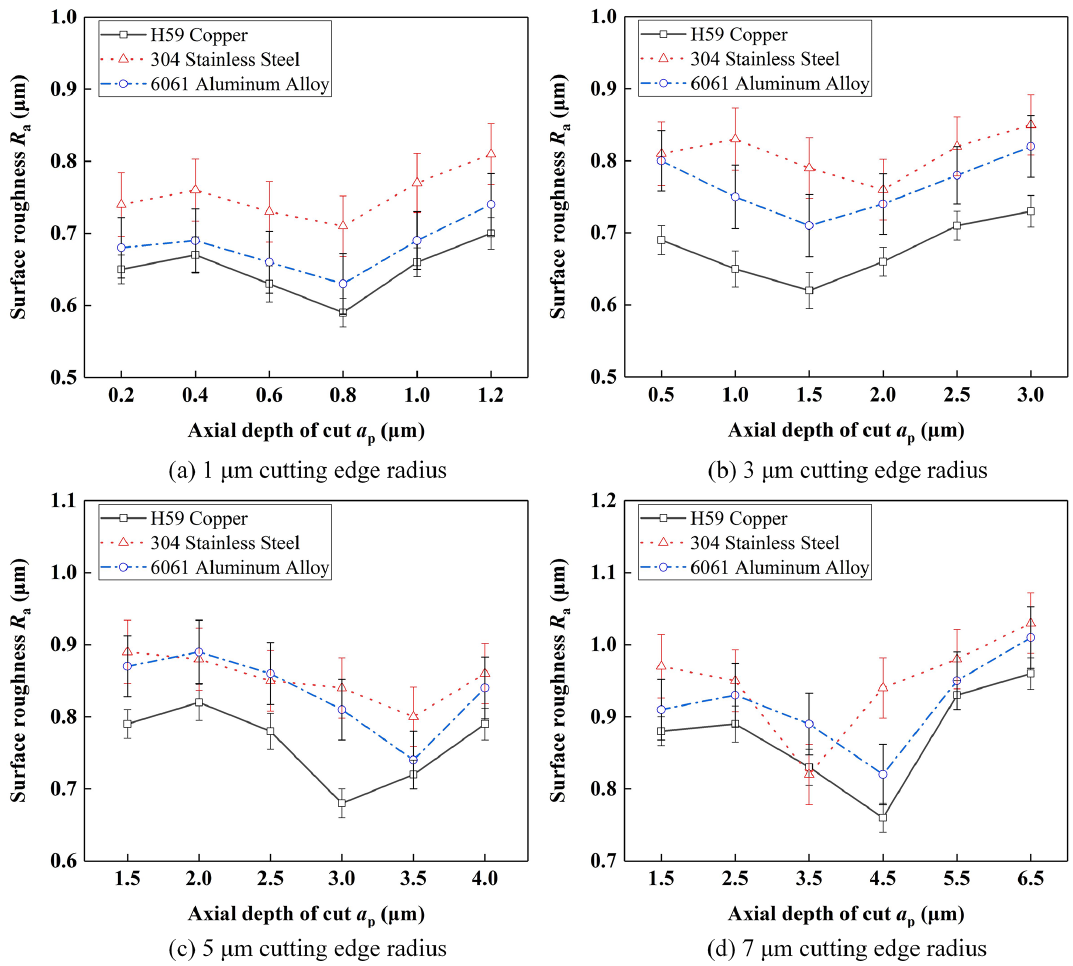
Figure 13. Surface roughness results for the end cutting edge.